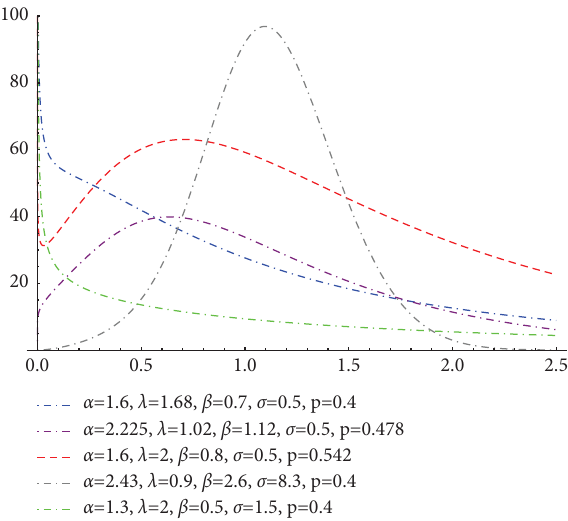
Figure 1: Te HRF of the PGcr/GeTNH model for diferent parameters values.